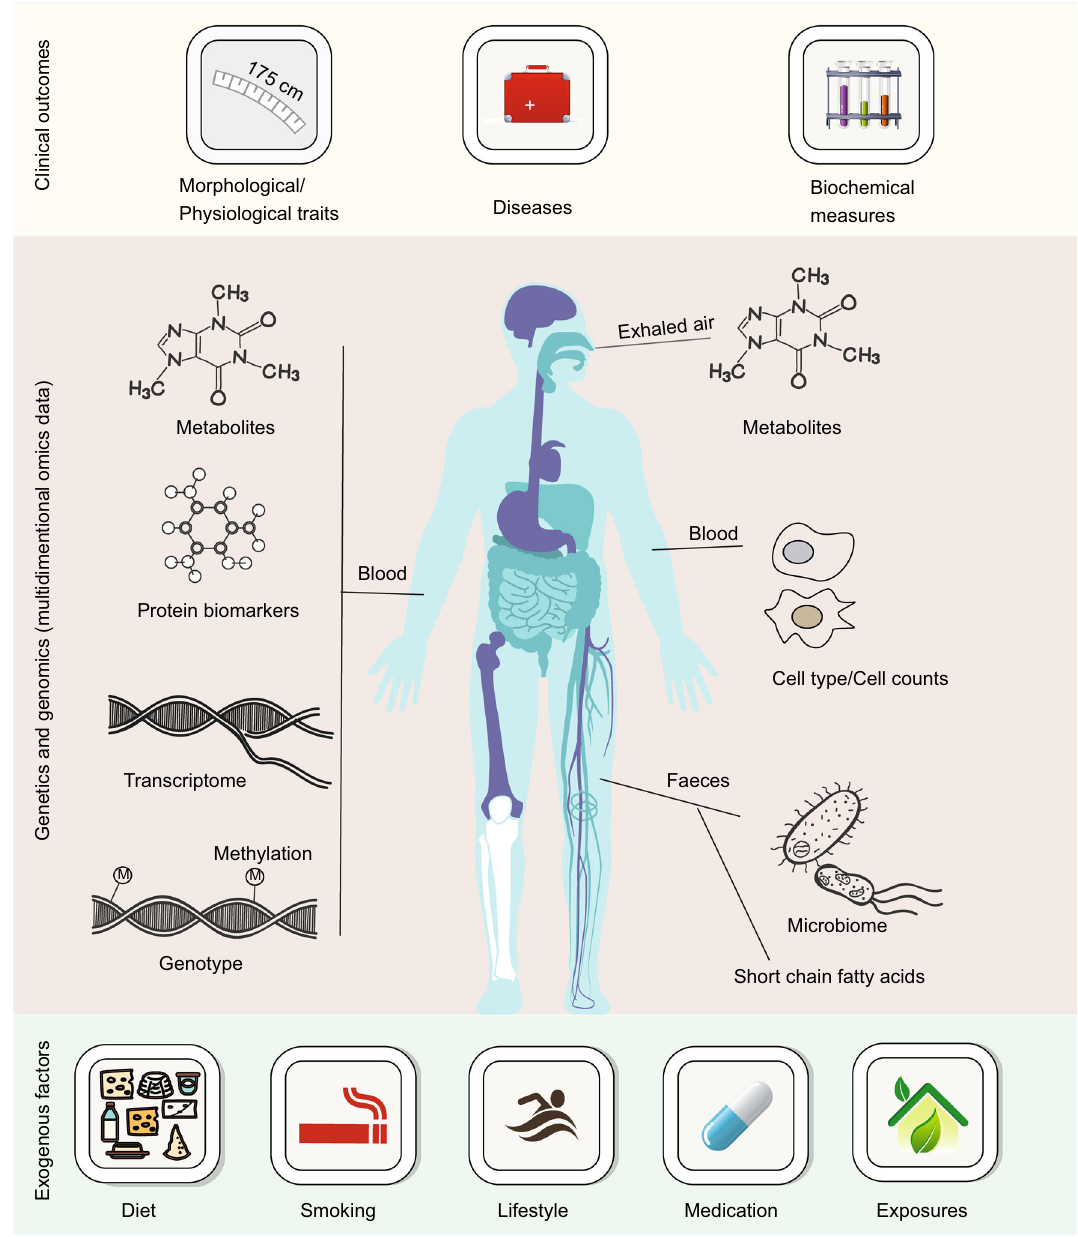
Figure 5. Overview of LifeLines-DEEP cohort. LifeLines-DEEP is a subset of 1,500 individuals from the large, prospective, population-based LifeLines cohort ( n = 167,000 individuals). In addition to information about >2,000 exogenous factors (morphological, physiological, clinical), LifeLines-DEEP participants have been deeply pro fi led for multiple “ omics ” data